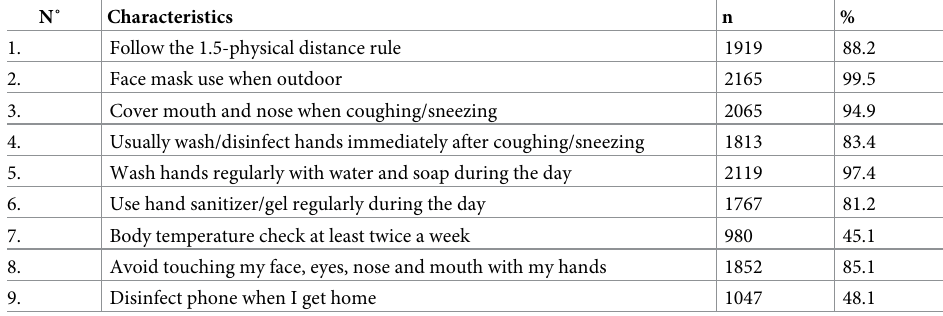
Table 3. Adherence to personal preventive measures for COVID-19.